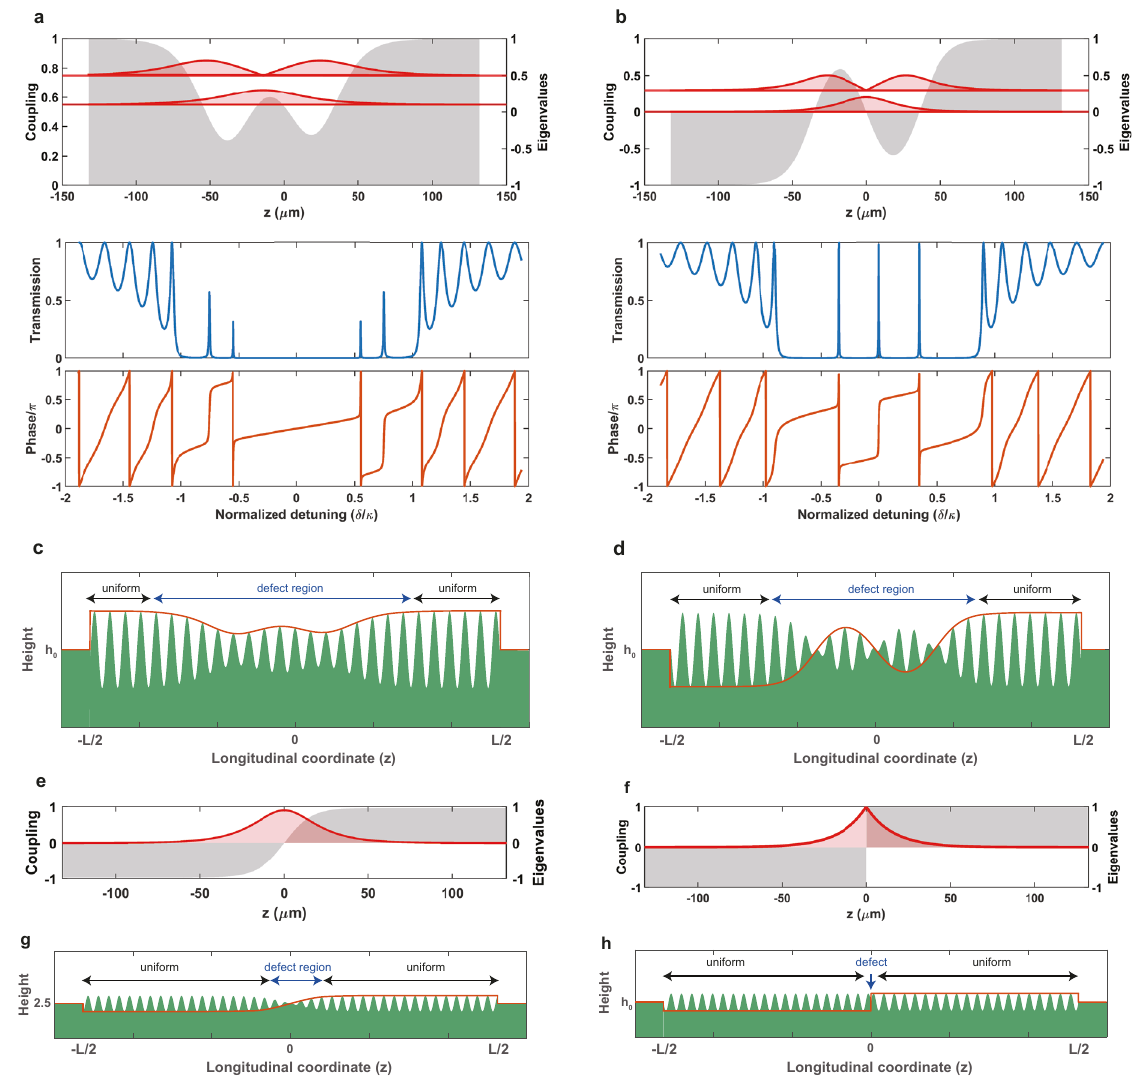
Fig. 3 Coupling potential and fi eld distribution obtained by SUSY transformation. a The coupling potential (shaded gray) derived by the SUSY method supports four modes at frequencies in the stopband. The modal energy distribution, which is the probability density of eigenfunction, is shown in red. The inserted states appear as transmission peaks and the corresponding phase change of π . Phase wrapping from [ − π , π ] leads to the sharp features at some resonant states. The fi nite length of the grating truncates the potential, which leads to the fi nite linewidth of each state. b An equivalent representation of the coupled-mode equation, where the coupling is pseudoscalar potential. It enables the design of a grating that supports states at the center of the stopband. c , d The design of grating with an envelope was obtained using SUSY transformation in a and b , respectively. The grating period has been magni fi ed for visualization. e Pseudoscalar potentials produce grating with adiabatic taper ( g ), leading to a phase shift for the zero detuning state. The modal energy distribution is smooth in the defect region. f In contrast, modal energy distribution in phase-shifted grating has an abrupt change ( h ), which leads to longitudinal hole burning in high-power the sign of the coupling contrasts the phase-shift layer, which acts as a point defect in the periodic structure that results in abruptness in the intra-cavity fi eld distribution, as shown in Fig. 3e, f. The advantage of smooth modal energy distribution is evident for high-power operation where irregular fi eld distribu- tion in phase-shifted DFB grating leads to longitudinal spatial hole burning. Various approaches, such as multiple phase shifts and chirped grating periods, lower the abruptness, reducing the fabrication tolerances. The smooth variation of fi elds near the defect region allows the devices to have easier fabrication, especially additive manufacturing techniques. Figure 3g, h illustrates the difference between a waveguide grating obtained using SUSY to insert state at zero detuning and phase-shifted grating. SUSY requires one defect region for multiple states,